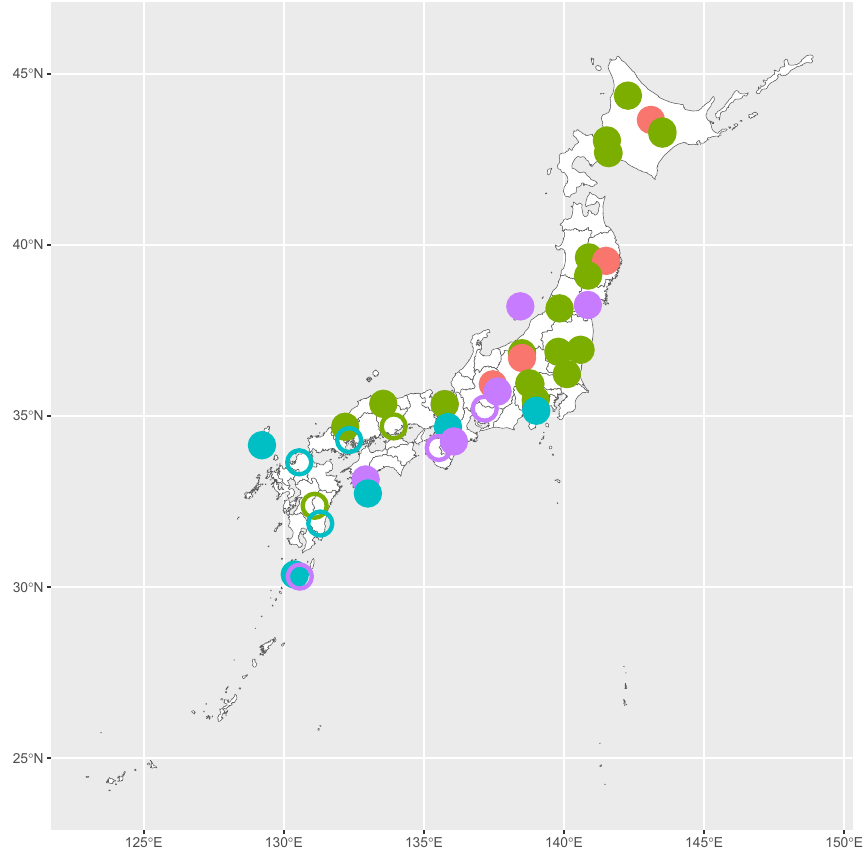
Figure 3. Distribution of the focal 42 forest plots across the Japanese archipelago. Point color and shape correspond to forest type and forest age, respectively. Red, boreal coniferous forest; green, deciduous broadleaved forest; blue, temperate coniferous forest; purple, evergreen broadleaved forest. Filled circle, old- growth forest; empty circle, secondary